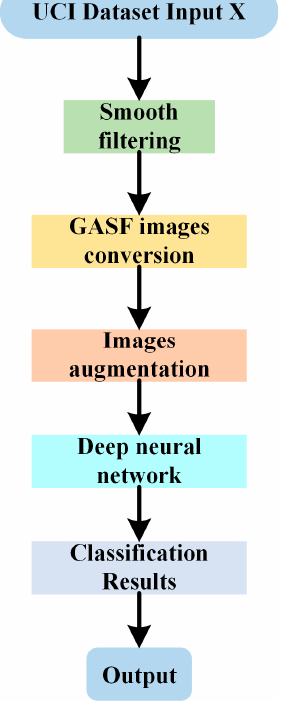
Figure 2. The flow chart of the whole experimental process.